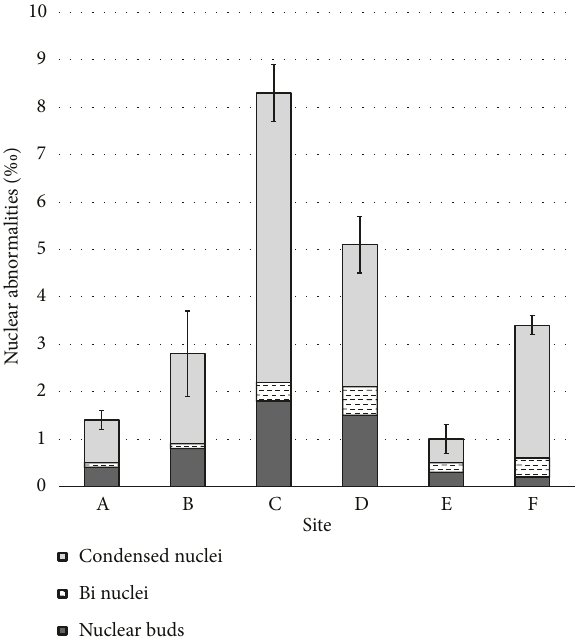
Figure 4: The percentage occurrence of nuclear abnormalities observed in the dividing cells of Allium cepa root tips exposed to water samples collected from the study sites in Dandugan oya.